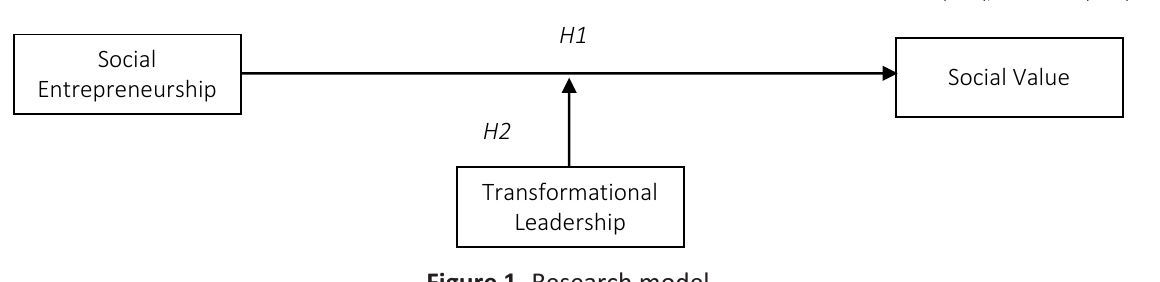
Figure 1. Research